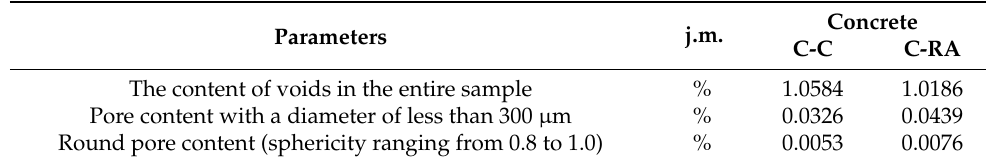
Table 13. Porosity parameters for C-C and C-RA series concrete, the volume of the samples was 1687.5 cm 2 .